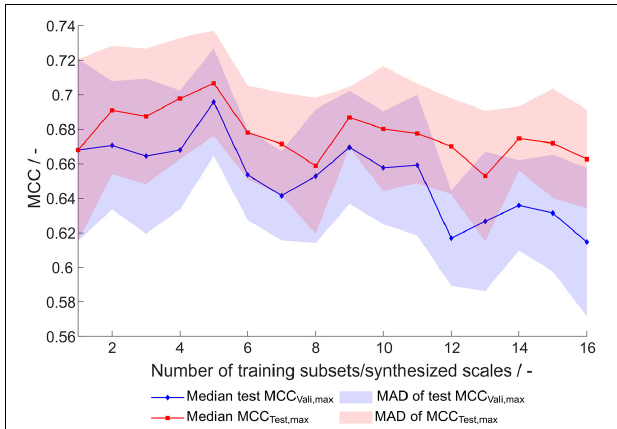
FIGURE 4 | Test set Matthew’s correlation coefficient (MCC) of synthesized scales. For each number of training subsets/synthesized scales, 20 repetitions of scale generation were performed. Median and median absolute deviation (MAD) of best test set MCC and test set MCC of best model by validation MCC are shown.